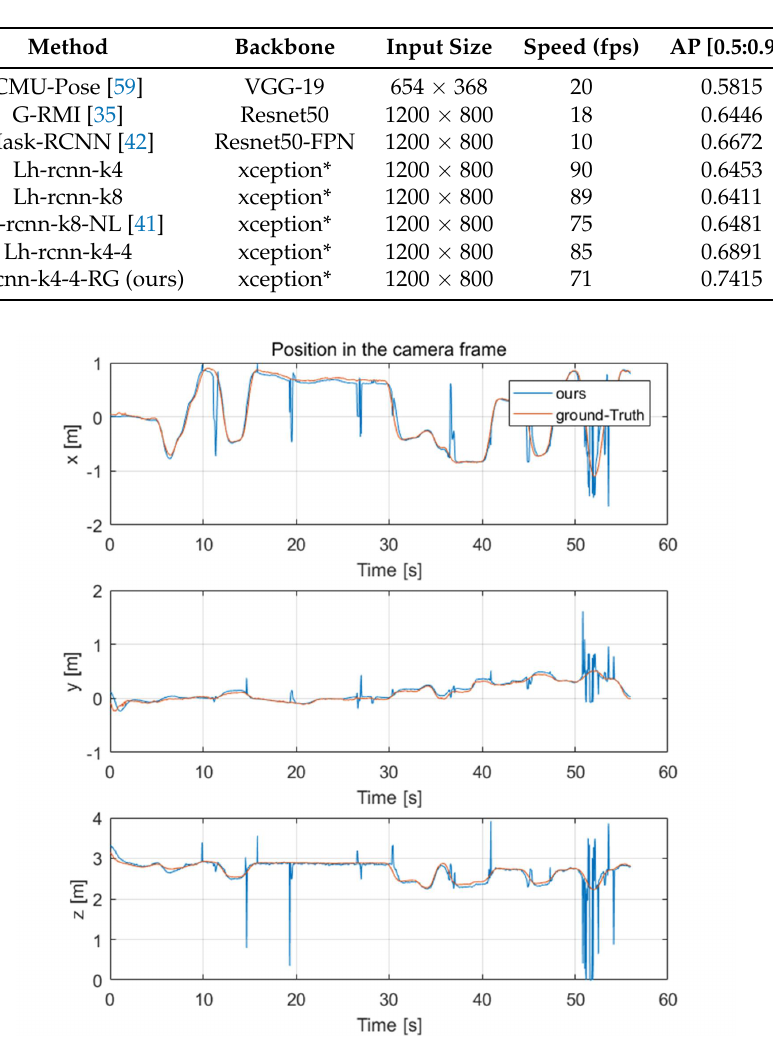
Table 5. Comparisons of detection speed and accuracy on Parrot indoor dataset. Xception* is a small xception like the backbone shown in Table 1. CMU -Pose [59], G-RMI [35] and Mask-RCNN [42] are human keypoints detection algorithms; we used it by modifying the human keypoints to quadrotor